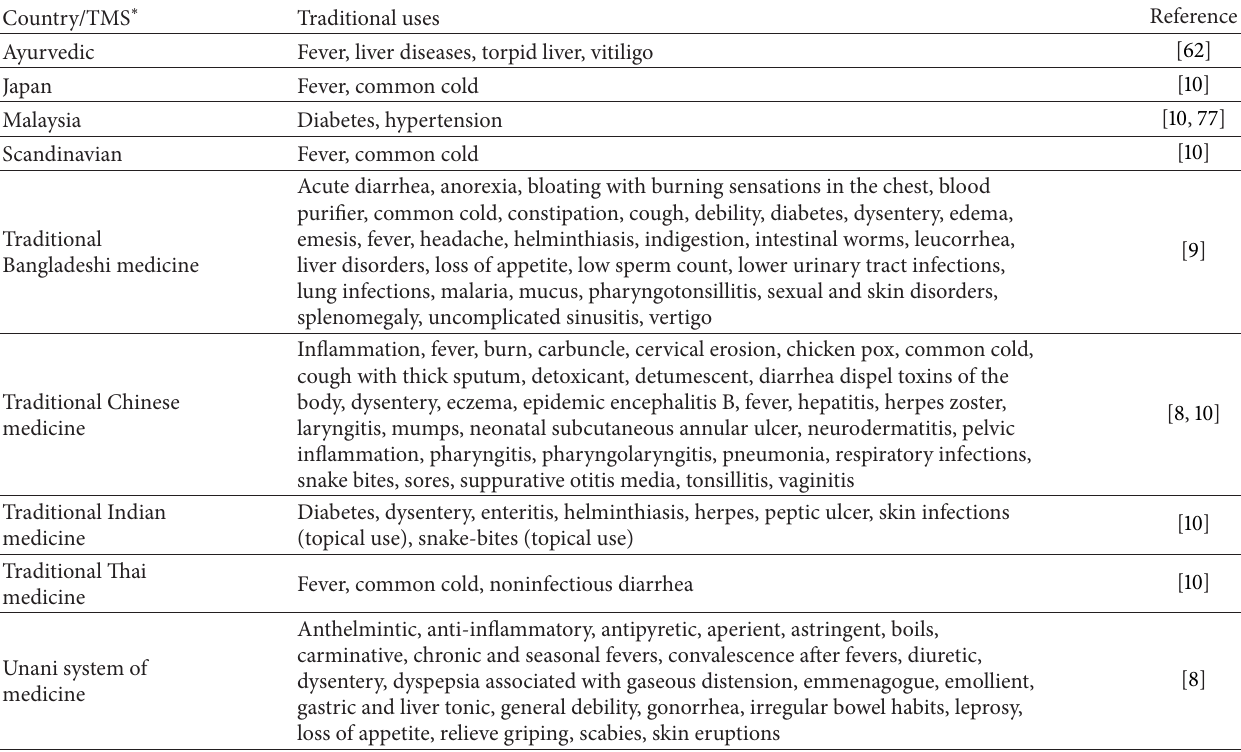
Table 3: The ethnobotanical uses of A. paniculata